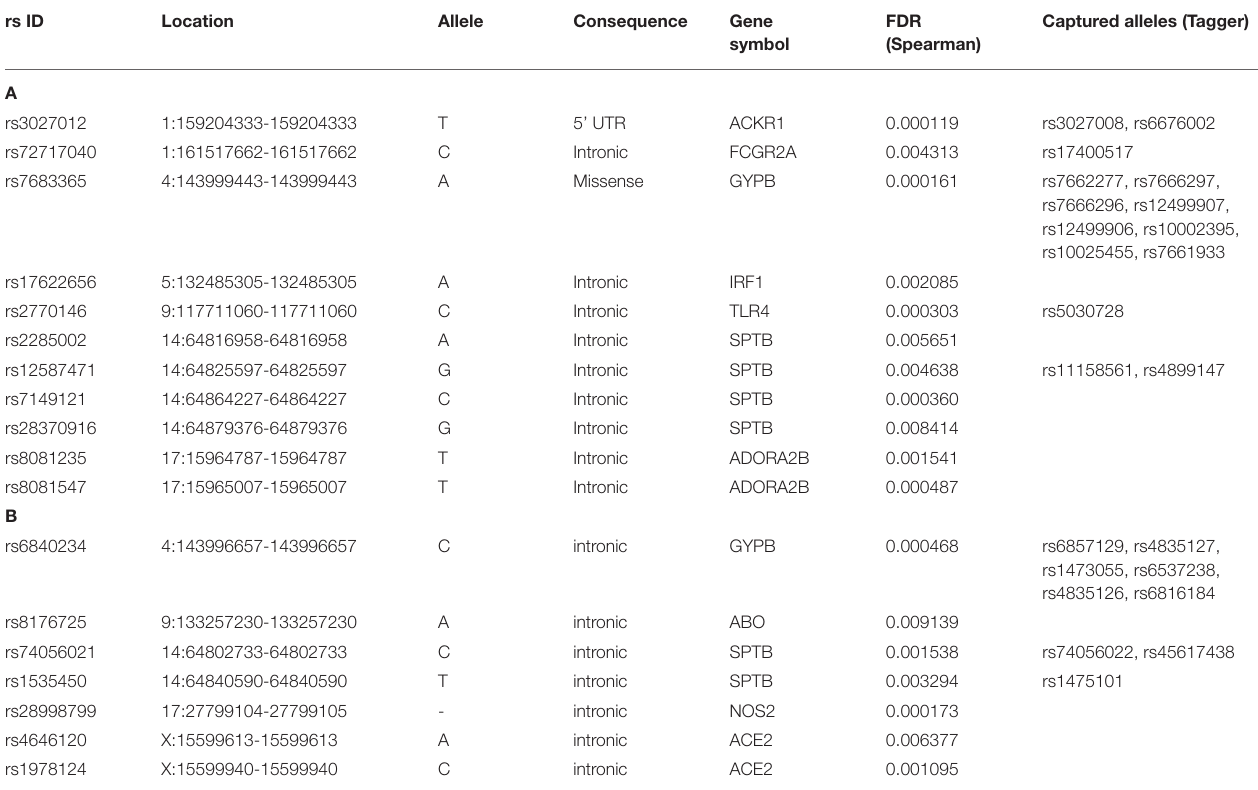
TABLE 3 | List of variants with (A) positive and (B) negative correlation (FDR < 0.01). rs